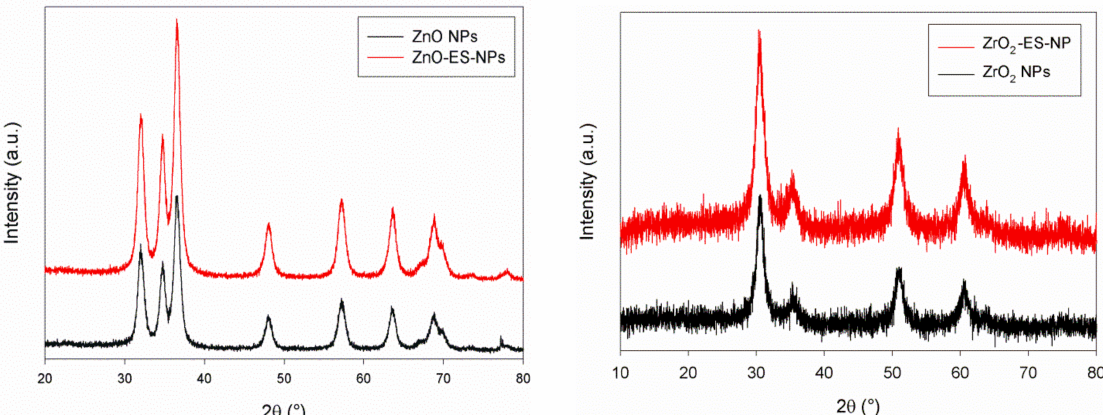
Figure 1. X-ray powder diffraction (XRPD) patterns of nanoparticles (NPs) and 3-glycidoxypropyltrimethoxysilane (GPTMS)-capped NPs: ZnO and ZnO-ES ( left ); ZrO 2 and ZrO 2 -ES ( right